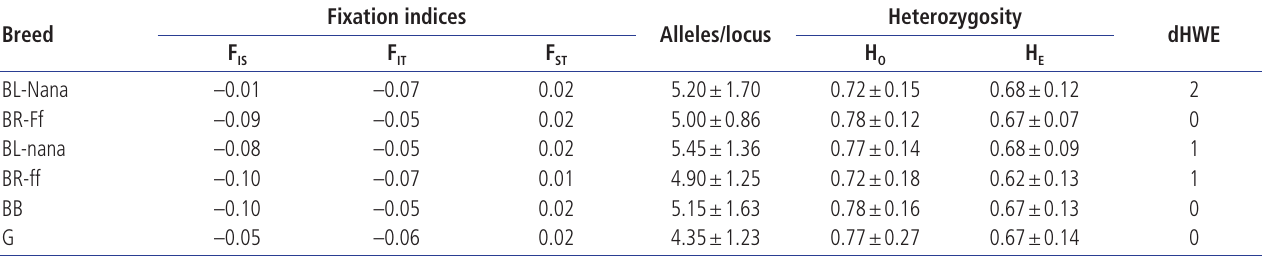
Fixation indices